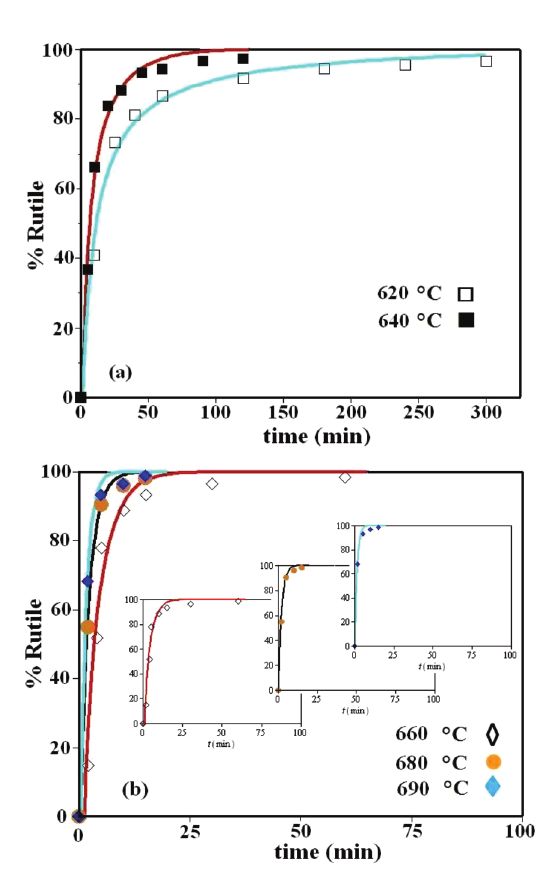
Fig. 3 – Points represent transformation experimental data from anatase to rutile 27 , and curves are fitted with Eq. (9)